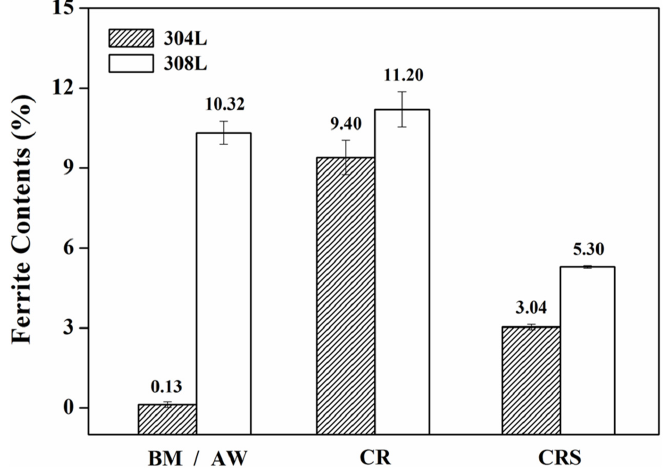
Figure 2. The ferrite contents of the 304L substrates and 308L deposits in distinct